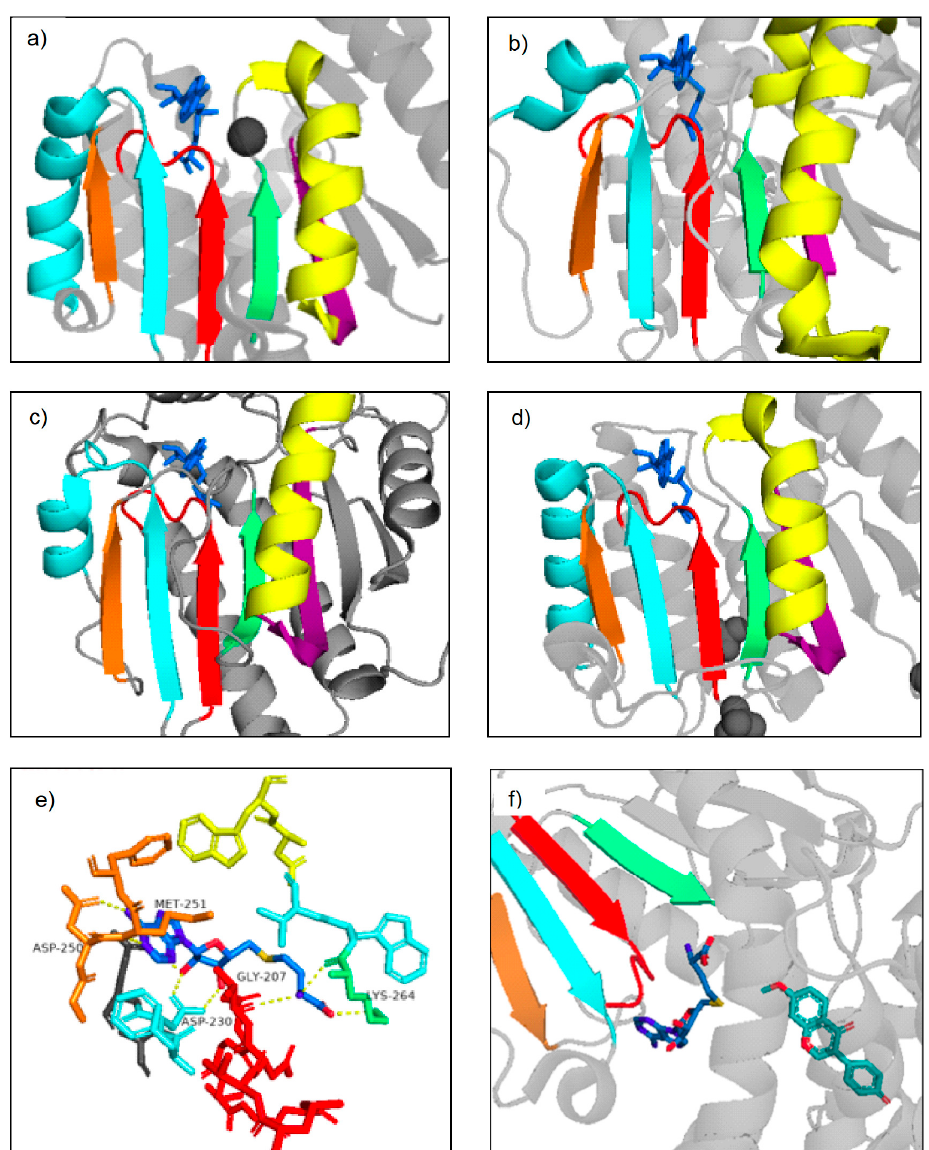
Figure 5. Rossmann fold motifs highlighted in Class I plant NPMTs and Class I bacterial MTs. Three-dimensional visualizations were created using PDB crystal structures and PyMOL. ( a ) Cation-dependent, SbCCoAOMT, ( b ) Cation-independent MtHI4 ′ OMT, ( c ) SABATH, CrLAMT, ( d ) bacterial Leptospira interrogans O-methyltransferase, LiOMT (PDB 2HNK), ( e ) closer look at the MtHI4 ′ OMT SAM-binding pocket, with important residues and hydrogen bonding highlighted, ( f ) representation of the methyl transfer between SAM and MtH14 ′ OMT. Species names and PDB numbers for the above-mentioned plant NPMTs can be found in Table 1. The colored beta sheets and alpha helices represent Motifs I-VI, which make up the characteristic MT Class I Rossmann fold. The red strand represents Motif I, the light blue strand and helix represents Motif II, the orange strand represents Motif III, the green strand represents Motif IV, the yellow helix represents Motif V, and the purple strand represents Motif VI. The darker blue structure is either SAM or its demethylated form, SAH. The lighter blue structure is the